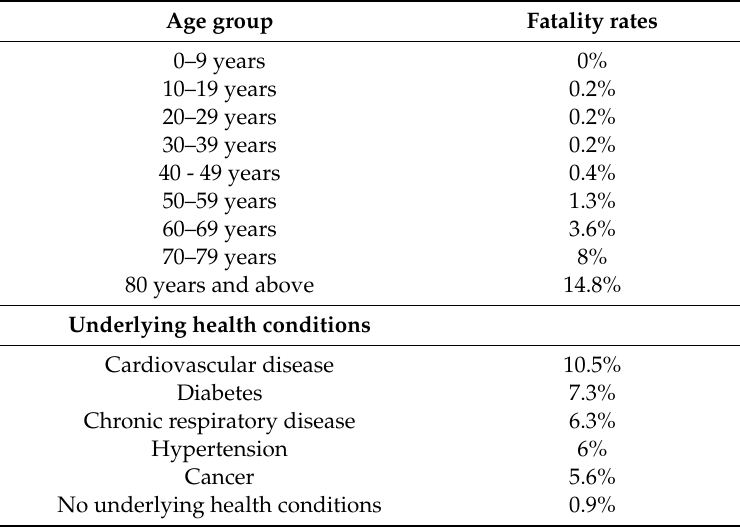
Table 1. Risk factor-based fatality rates of Covid-19 from early data in